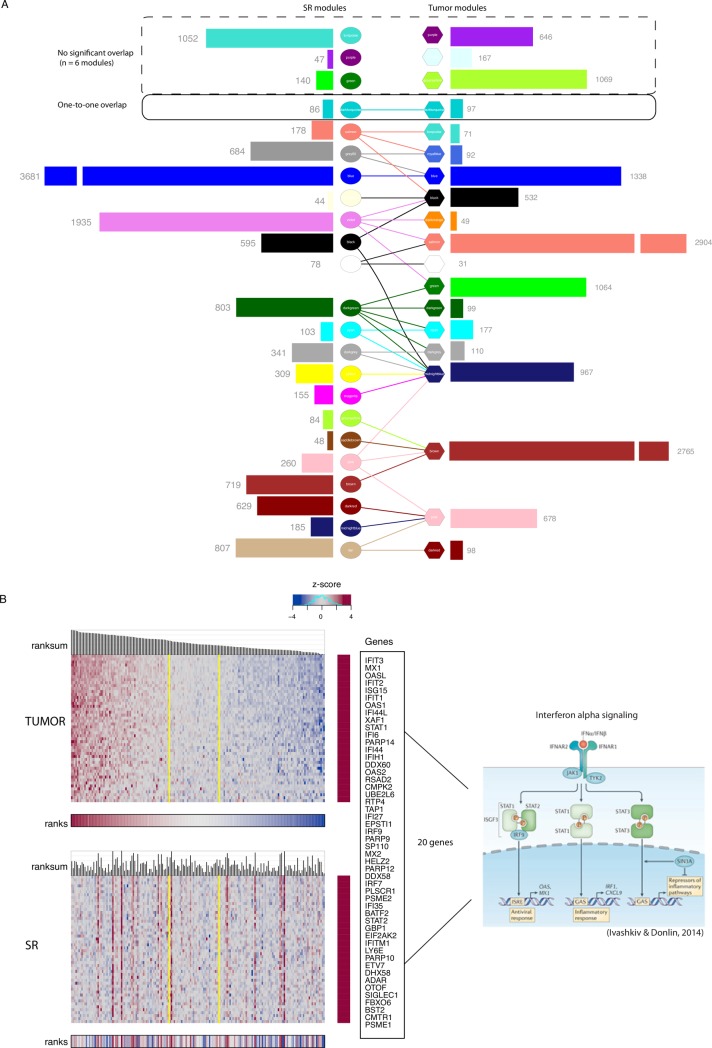
Modules size and overlap in their gene composition across tissues.(A) Histograms depicting number of genes composing modules in each tissue. Edges between modules indicate significant overlaps in gene composition (Fisher exact test, fdr < 0.01). (B) Expression heatmaps of the 47 genes included in both darkturquoise modules in tumor (upper) and SR (lower). Patients in both heatmaps are linearly ordered based on their ranksum of gene expression in tumors. Yellow vertical lines delimit the region of Independence (ROI95) in tumor that contains 95% of randomly generated samples. Twenty genes out of the 47 common genes are involved in the type 1 IFN signaling pathway (IFN alpha signaling pathway is depicted on the right).